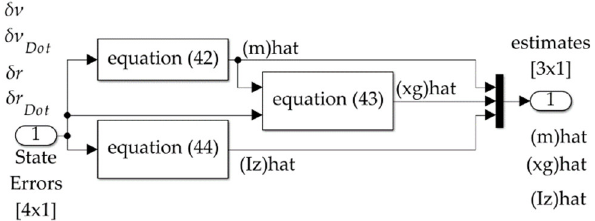
Figure 7. Simple learning topology manifest as a SIMULINK simulation program representing the upper left subsystem in Figure 6.